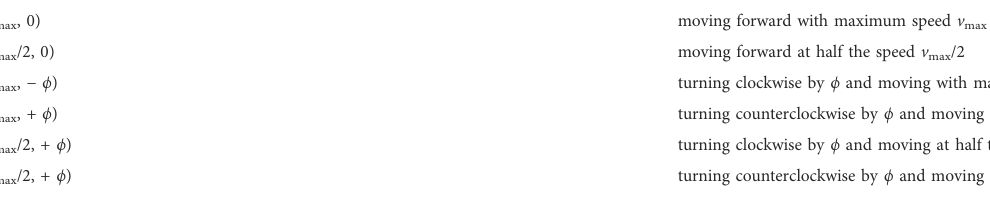
TABLE 1 Description of the actions of the